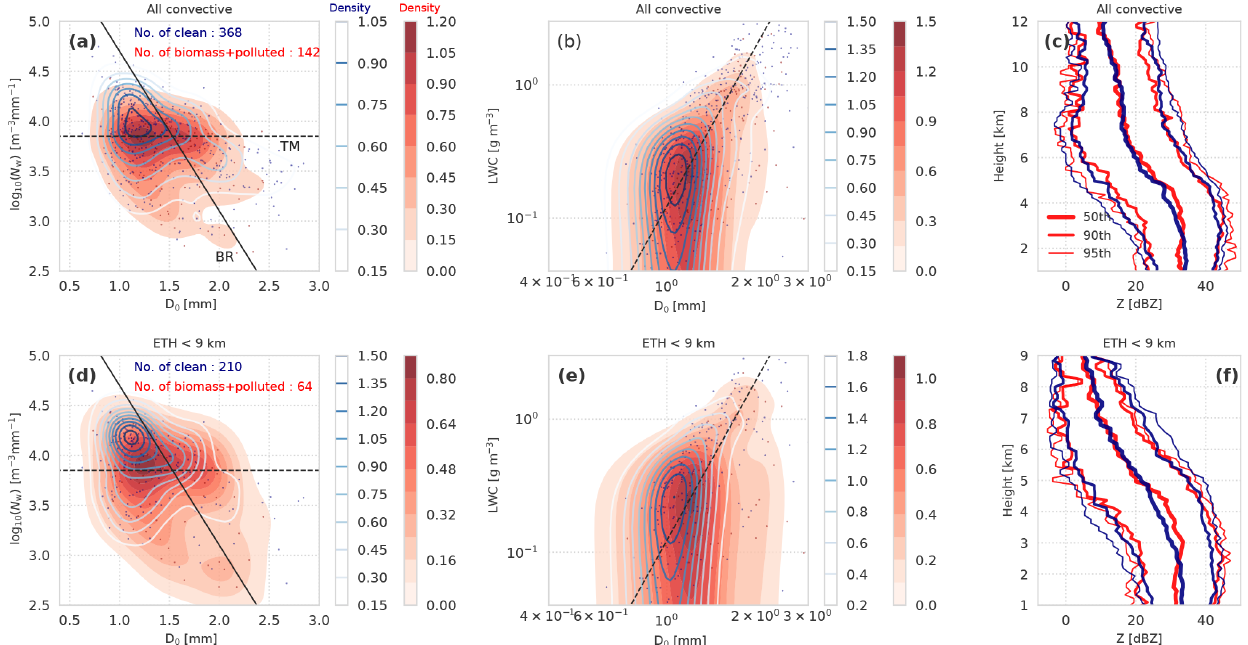
Figure 15. Scatter plots of log 10 ( N w ) versus D 0 and LWC versus D 0 for RWP-based convective DSDs under the wet season (a, b) , as well as for only congestus convective DSDs (d, e) , contouring the clean (blues) and polluted (reds) conditions. The corresponding composite median and 90th and 95th percentile RWP Z profile behaviors under the clean (blue) and polluted (red) conditions are shown in (c) and (f)